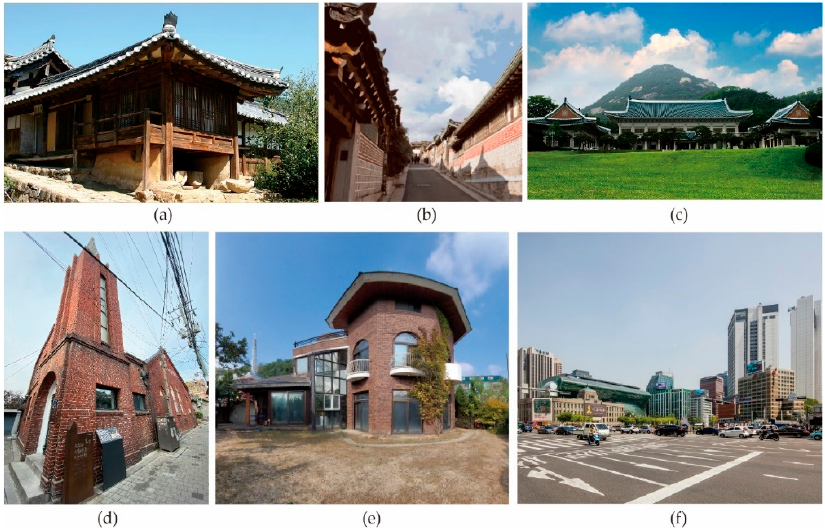
Figure 1. Various types of architectural asset. ( a ) Hanok built in 1776 (Unjoru) [4]; ( b ) urban type Hanok in the early 1900s (Bukchon Area, Seoul) [5]; ( c ) Hanok made of concrete structures have the potential to receive support under the VEHAA Act. (the Blue House, the Korean presidential residence) [6]; ( d ) modern architectural built in 1931 (chebu-dong church) [7]; ( e ) modern architectural built in 1983 (sajik-dong house) [8]; ( f ) contemporary architectural landscape in Seoul, South Korea (around Seoul city hall) [9].